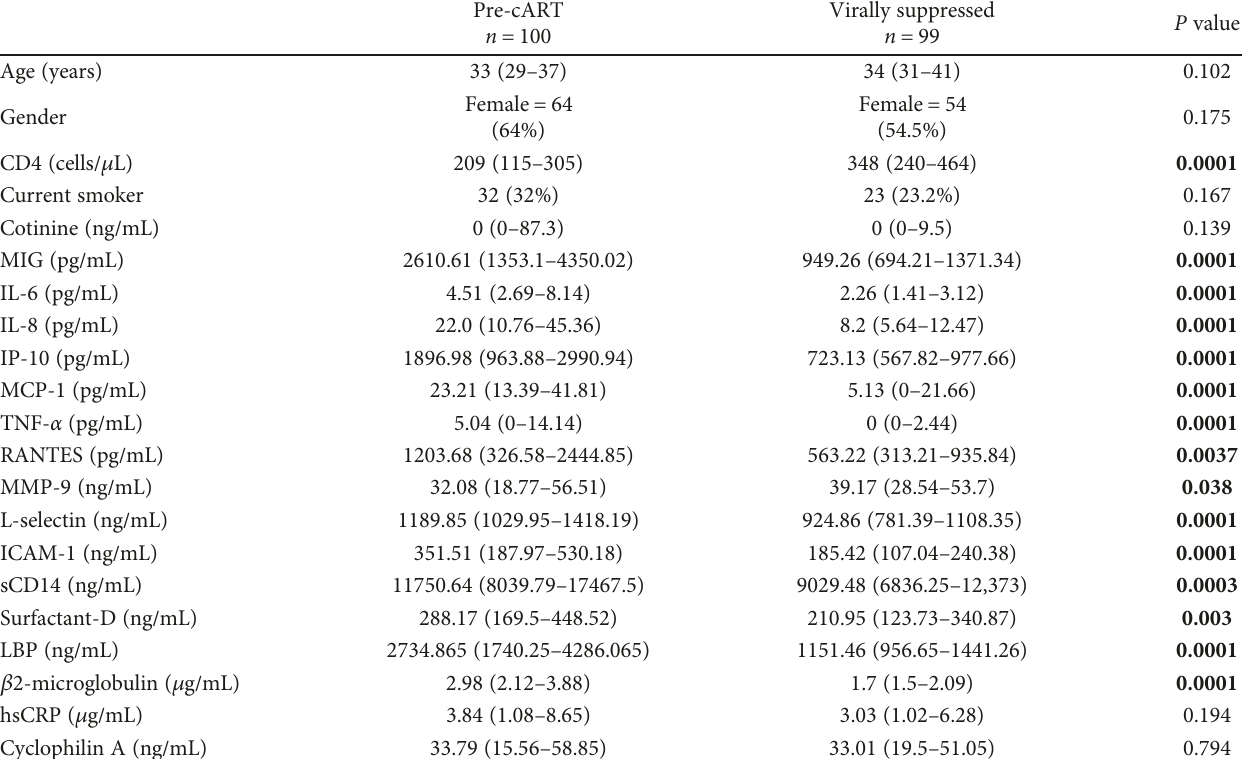
Table 1: Demographic, clinical, and biomarker results of pre-cART and virally suppressed